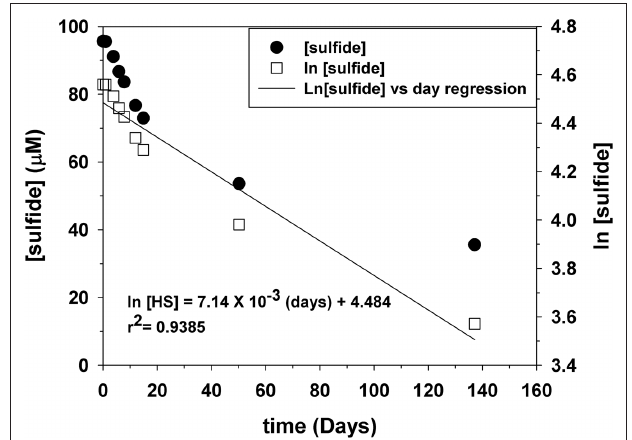
Figure 4 | representative plot for the kinetics of sulfide oxidation in air saturated water under trace metal clean conditions. The ln of the sulfide concentration versus time shows pseudo first order behavior.